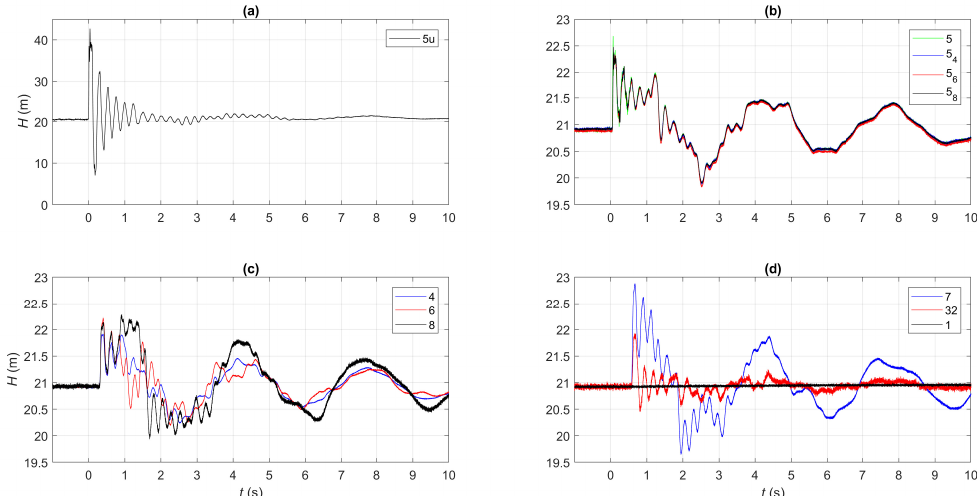
Figure 3. Test #1—pressure signals acquired at measurement sections: ( a ) 5u; ( b ) 5, 5 4 , 5 6 , and 5 8 ; ( c ) 4, 6, and 8; ( d ) 7, 32, and 1. Note that to highlight the pressure variations into the network, the y-axis of ( b – d ) is significantly reduced with respect to the one at 5u ( a